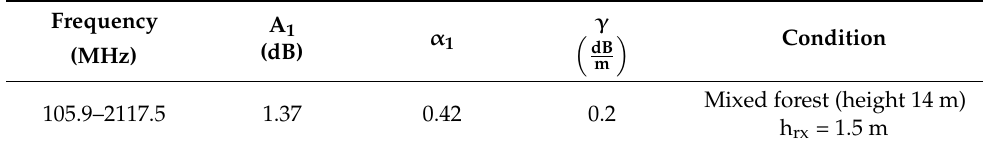
Table 5. Empirical parameters recollected from ITU P.833-9